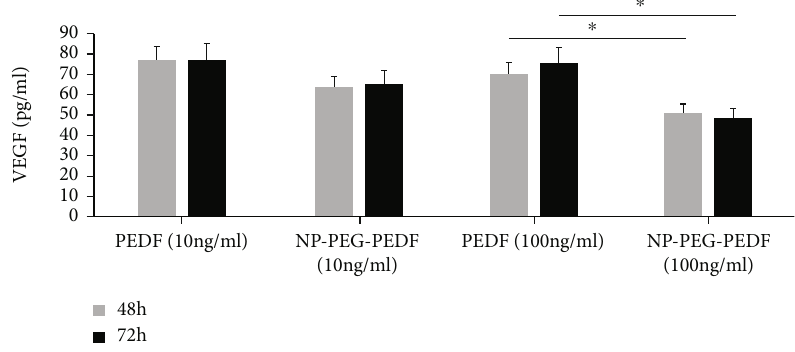
Figure 9: E ff ects of PEDF and NP-PEG-PEDF treatment on VEGF secretion in HUVECs. The NP-PEG-PEDF-treated group (100ng/mL) exhibited signi fi cant suppression in VEGF secretion at both 48 and 72 h ( p < 0 : 05 ). Table 4: Summary of VEGF secretion (pg/mL) in PEDF- and NP-PEG-PEDF-treated HUVECs. Time